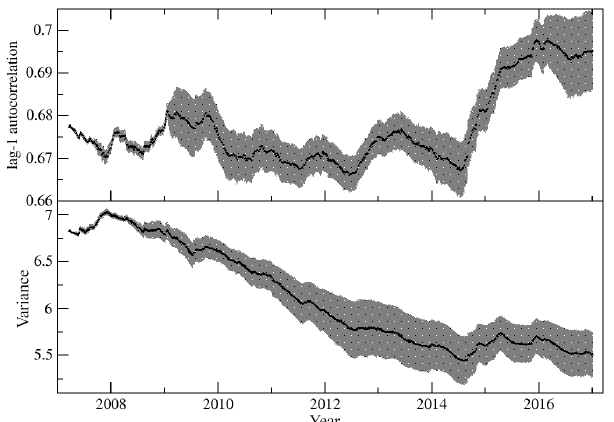
Figure 4. Early-warning indicators of the broadband SPL dataset: lag-1 autocorrelation (upper panel) and variance (lower panel), cal- culated with variable window lengths, from 1 / 4 to 3 / 4 of the record length, and corresponding standard uncertainties, displayed at the end of each window. Both indicators demonstrate nonstationary be- haviour (increasing autocorrelation and decreasing variance), which denotes long-term development a possible future tipping.